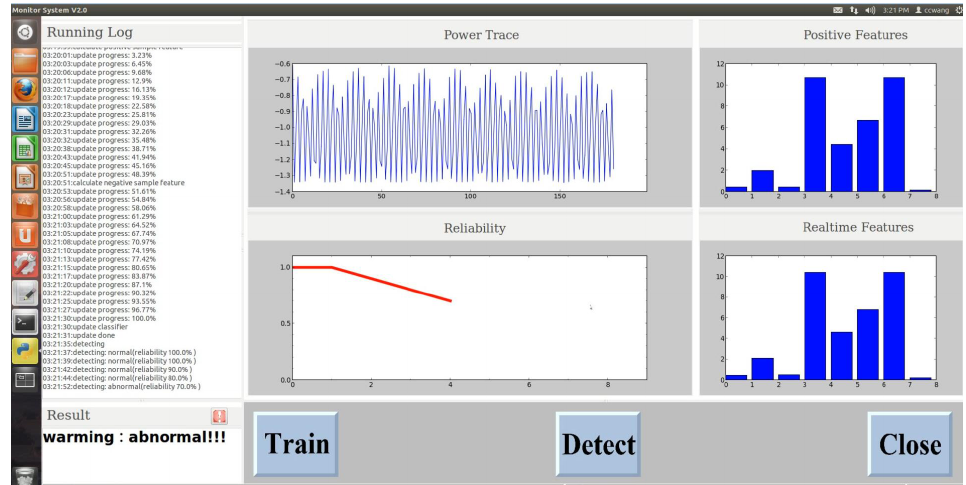
Figure 7. The UI snapshot of the real-time monitoring